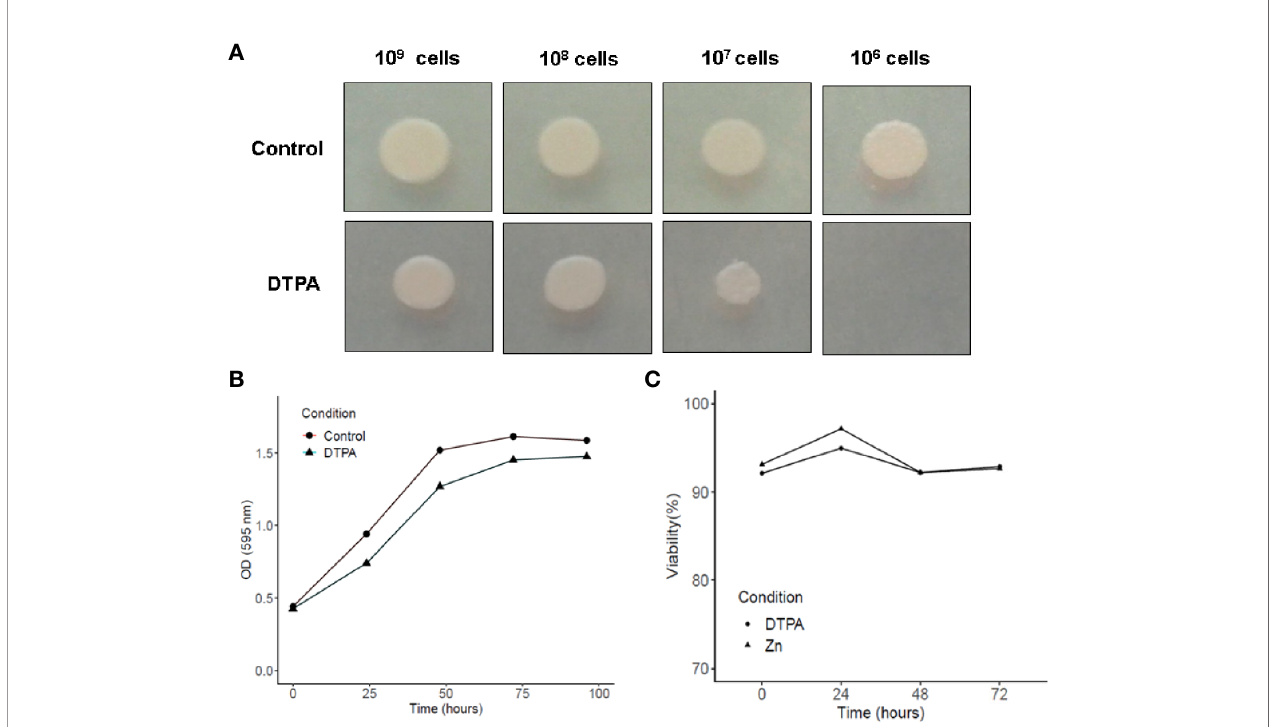
FIGURE 1 | In fl uence of Zn availability on H. capsulatum growth and viability. (A) Growth in solid MMcM medium during 5 days with 20 m M of ZnSO 4 or 100 m M DPTA. (B) Growth of H. capsulatum in liquid medium was measured by optical density at 595 nm. (C) Viability of H. capsulatum in liquid medium was assessed by trypan blue dye. Growth and viability experiments were carried out in biological triplicates.